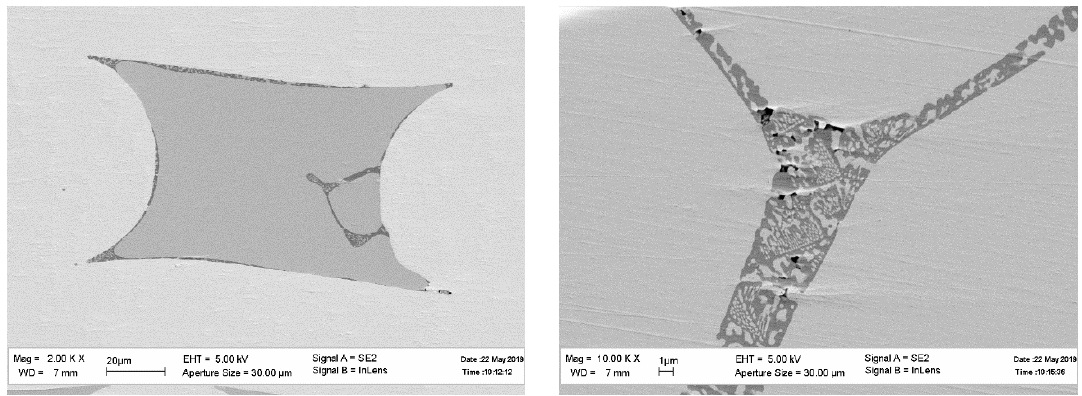
Figure 10. SEM micrographs of the cross-section of the fibers obtained according to the second crystallization scheme.